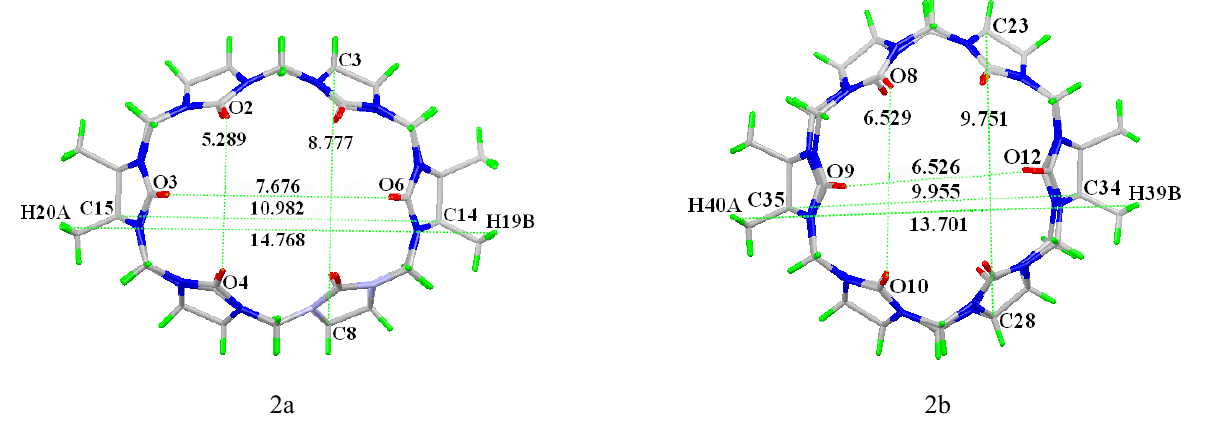
Figure 2. Two different styles of TMeQ[6] molecules (a) Q1 and (b) Q2.